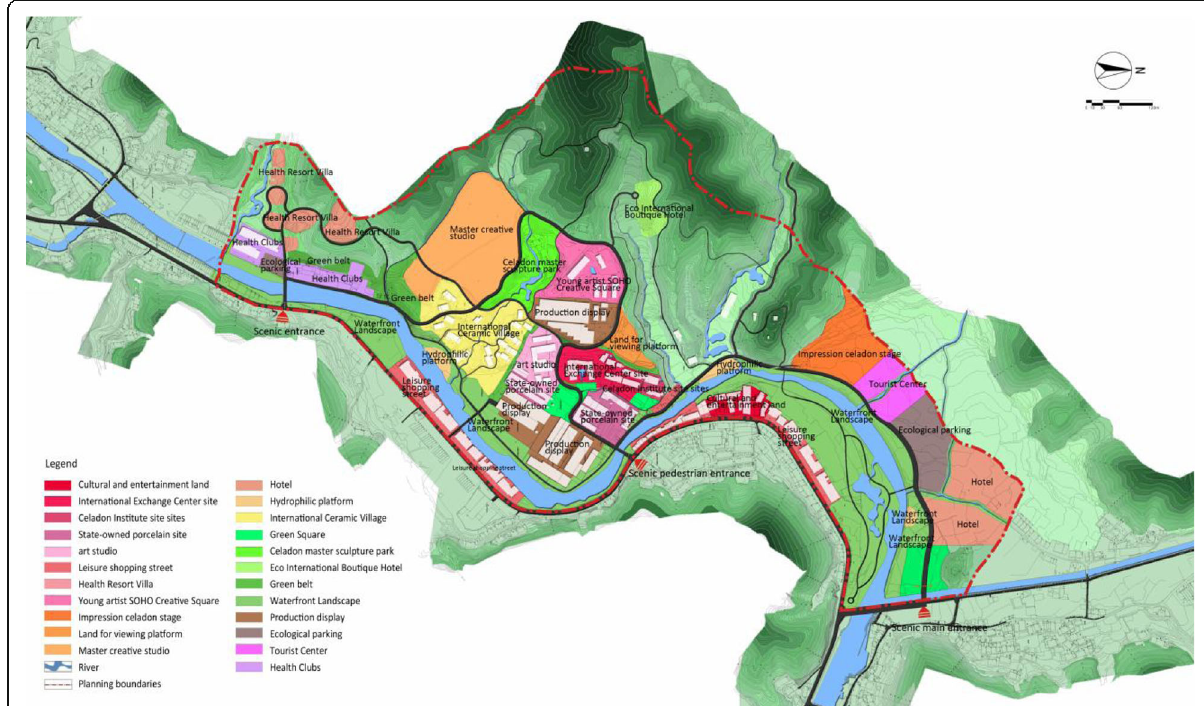
Fig. 5 General plan of Longquan celadon cultural industrial